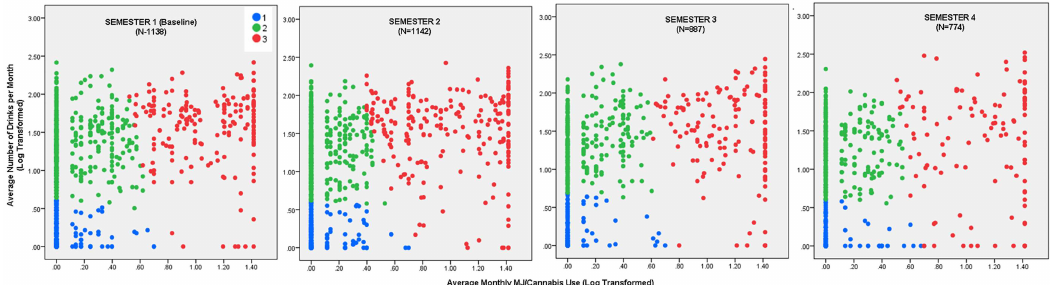
Fig 1. Substance use patterns. Scatter plots of alcoholand marijuanausageamong students across semesters.